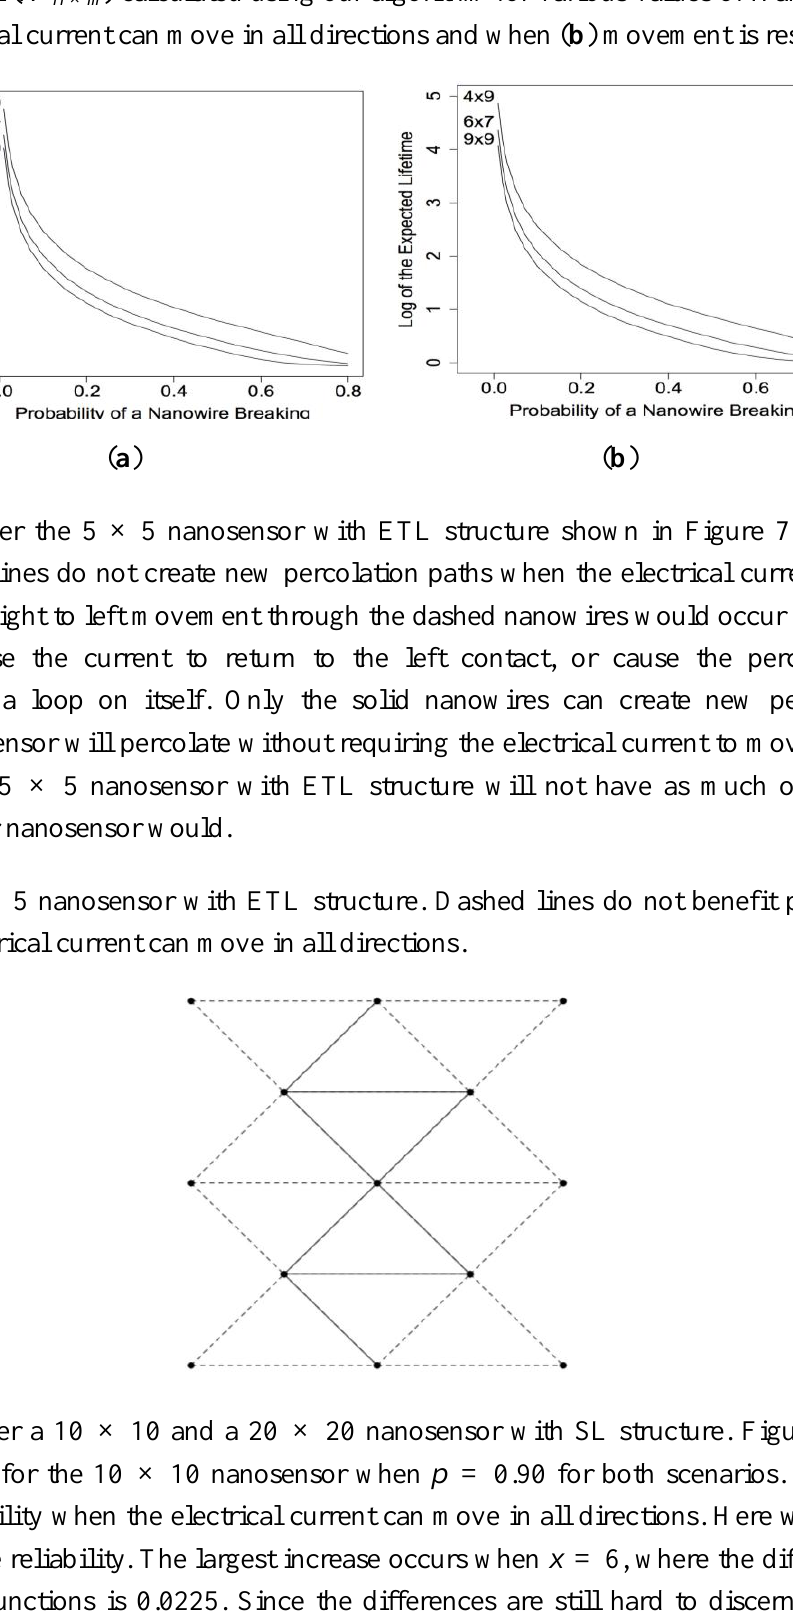
Figure 6. log E ( X H ) calculated using our algorithm for various values of n and m when n × m